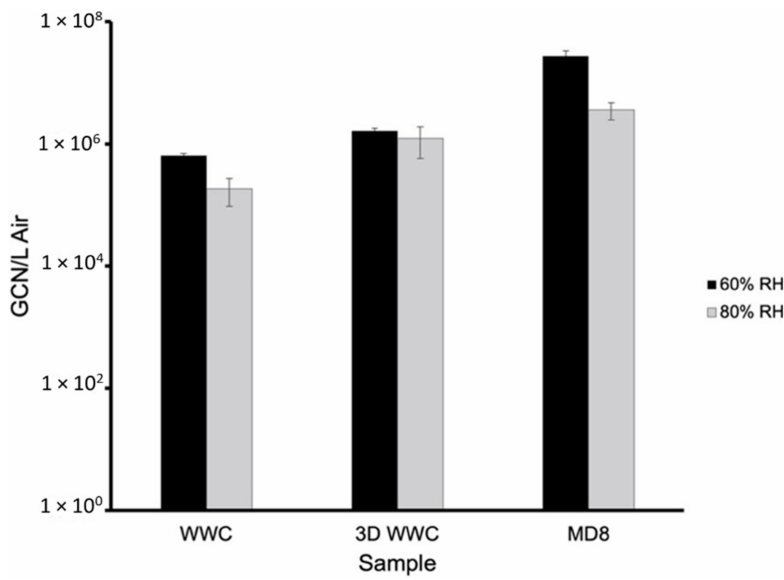
Figure 7. GCN/L Air of BCoV at 25 ◦ C and 60% and 80% relative humidity of aerosol samples collected by the WWC, 3D WWC, and the MD8 sampler (Table S2 in Supplementary